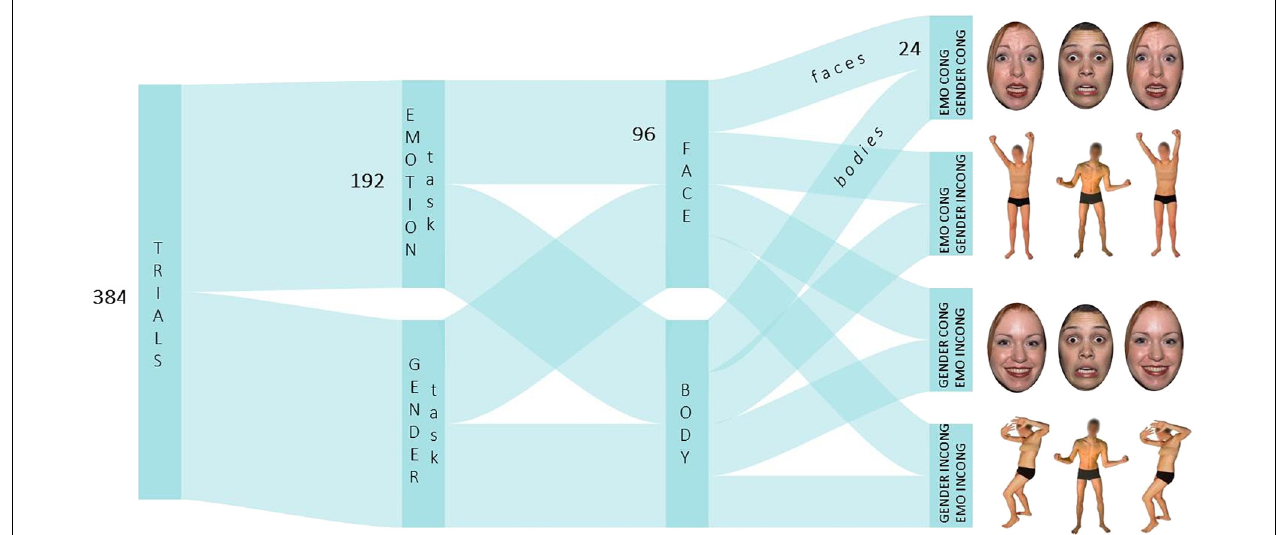
FIGURE 1 | Schematic depiction of the task structure in Experiment 1 and Experiment 2.